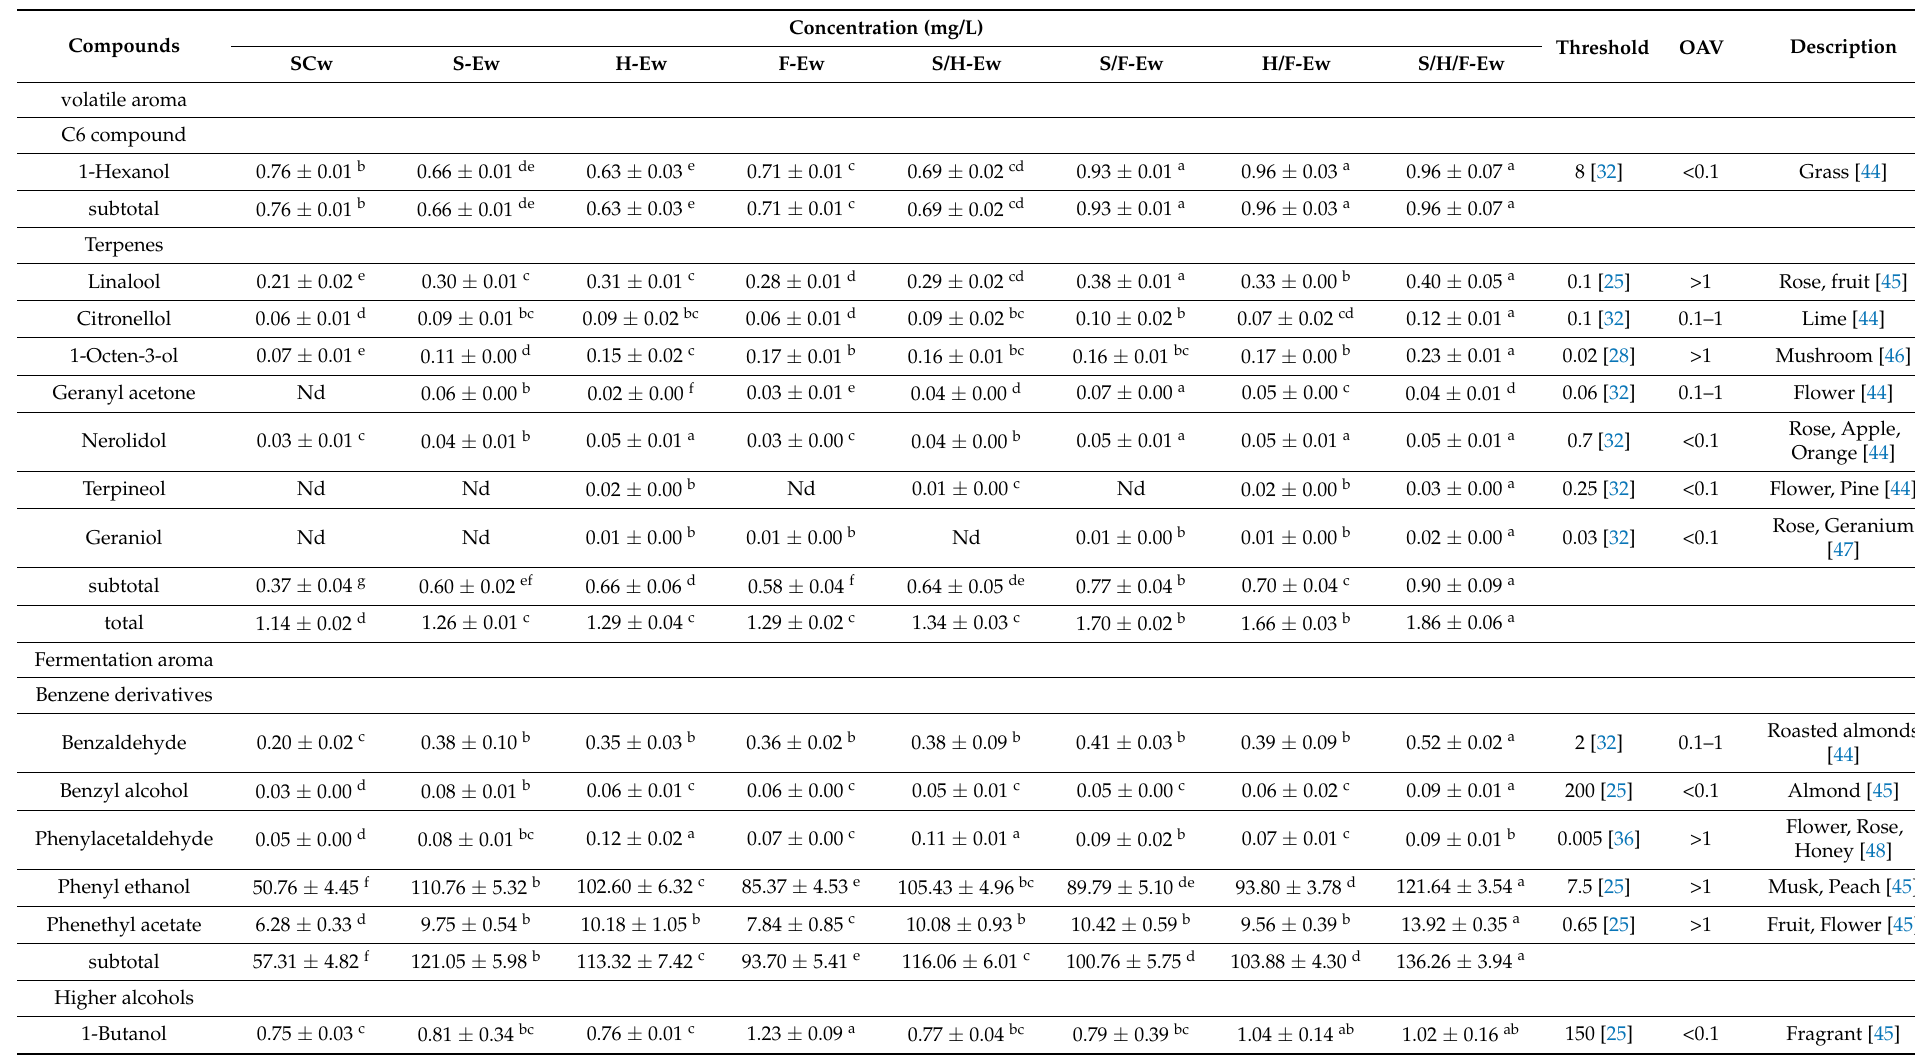
Table 3. Volatile aroma compound concentration in wine treated by adding mixed yeast